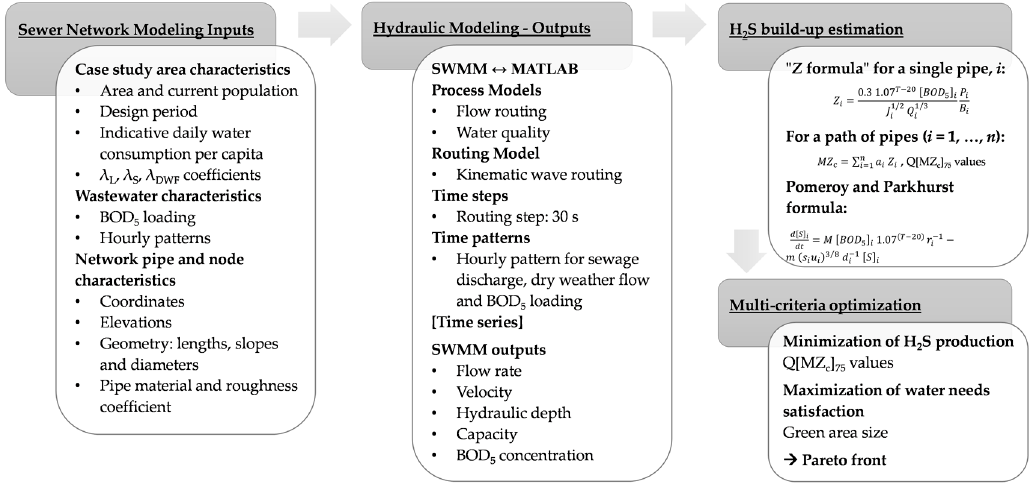
Figure 6. Modeling procedure and components.